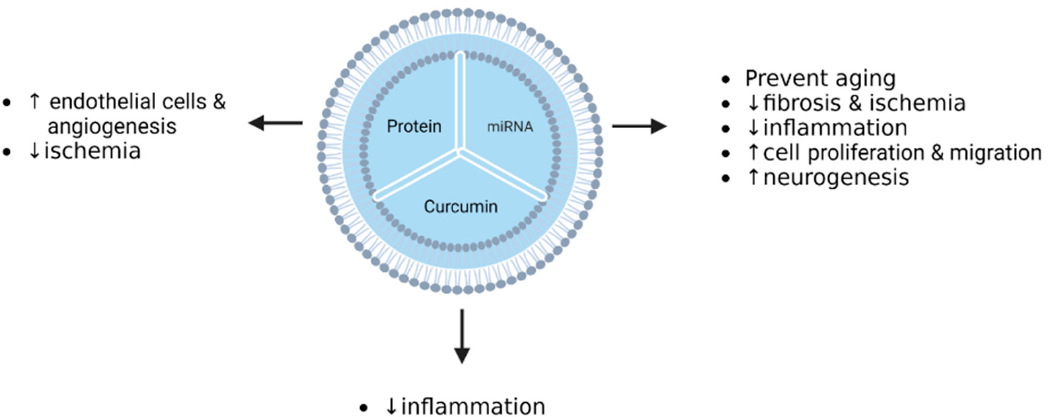
Figure 5. Summary of EV cargos and their effects on non-cancerous pathologies in vitro ( ↑ : increase, ↓ : decrease).